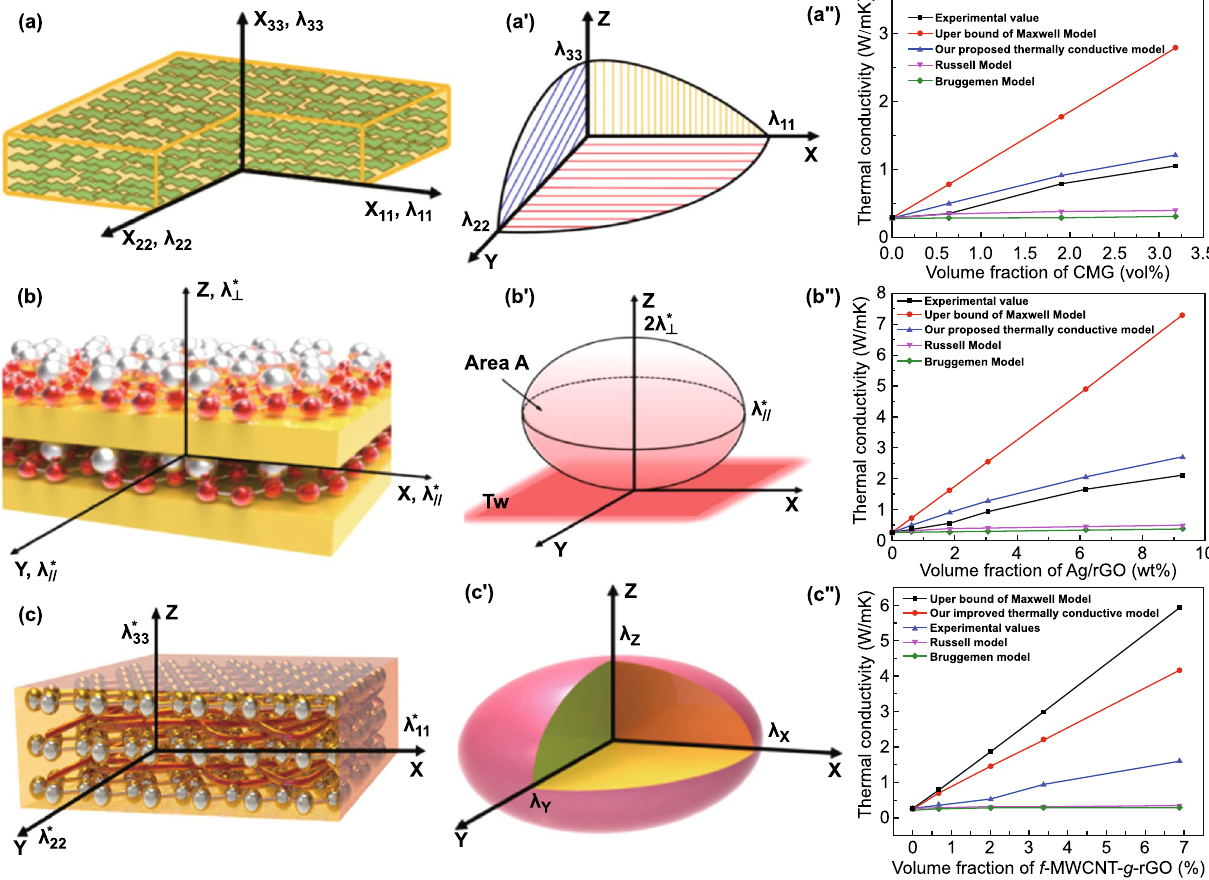
Fig. 3 Schematic diagrams of proposed thermal conduction models and comparison with traditional models for thermally conductive CMG/PI ( a–a ′′ ) [24], Ag/rGO/PI ( b–b ′′ ) [25] and f-MWCNTg-rGO/PI ( c–c ′′ ) [26]